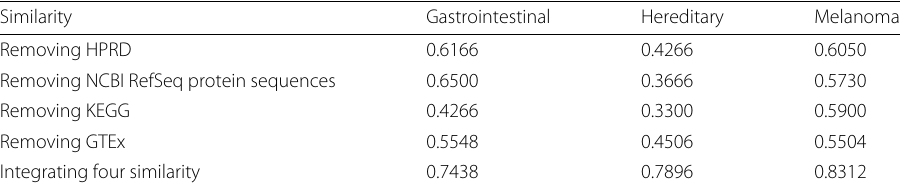
Table 2 Precision of driver gene detection after elimination of each similarity matrix Similarity Gastrointestinal Hereditary Melanoma Removing HPRD 0.6166 0.4266 0.6050 Removing NCBI RefSeq protein sequences 0.6500 0.3666 0.5730 Removing KEGG 0.4266 0.3300 0.5900 Removing GTEx 0.5548 0.4506 0.5504 Integrating four similarity